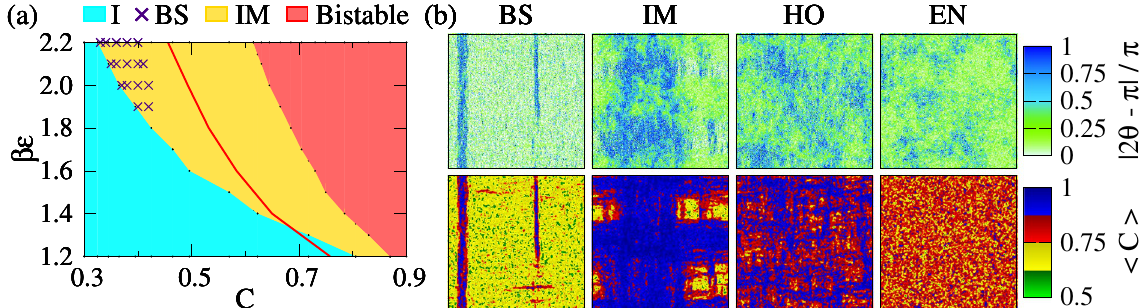
Figure 1. Phase diagram. ( a ) Phase diagram for both the equilibrium and the active nematic in the density - inverse temperature plane. The equilibrium system remains in the isotropic (EI) state in the low density regime (on the left of the solid line) and in the nematic (EN) state in the high density regime (on the right of the solid line). The active nematic goes from the disordered isotropic (I) state to the locally ordered inhomogeneous mixed (IM) state with increasing density or decreasing temperature. The I - IM transition occurs with the appearance of clear bands (BS) in the low temperature regime. In the high density regime the active nematic shows bistability between the IM and the homogeneous globally ordered (HO) state. ( b ) Upper panel shows particle inclination towards the horizontal direction. Colour bar ranging from zero to one indicates vertical to horizontal orientation, respectively. BS is the banded state configuration shown for ( βε , C ) = (2.0, 0.38). IM, HO and EN state configurations are shown for ( βε , C ) = (2.0, 0.78). Lower panel shows the coarse-grained density in the respective states.